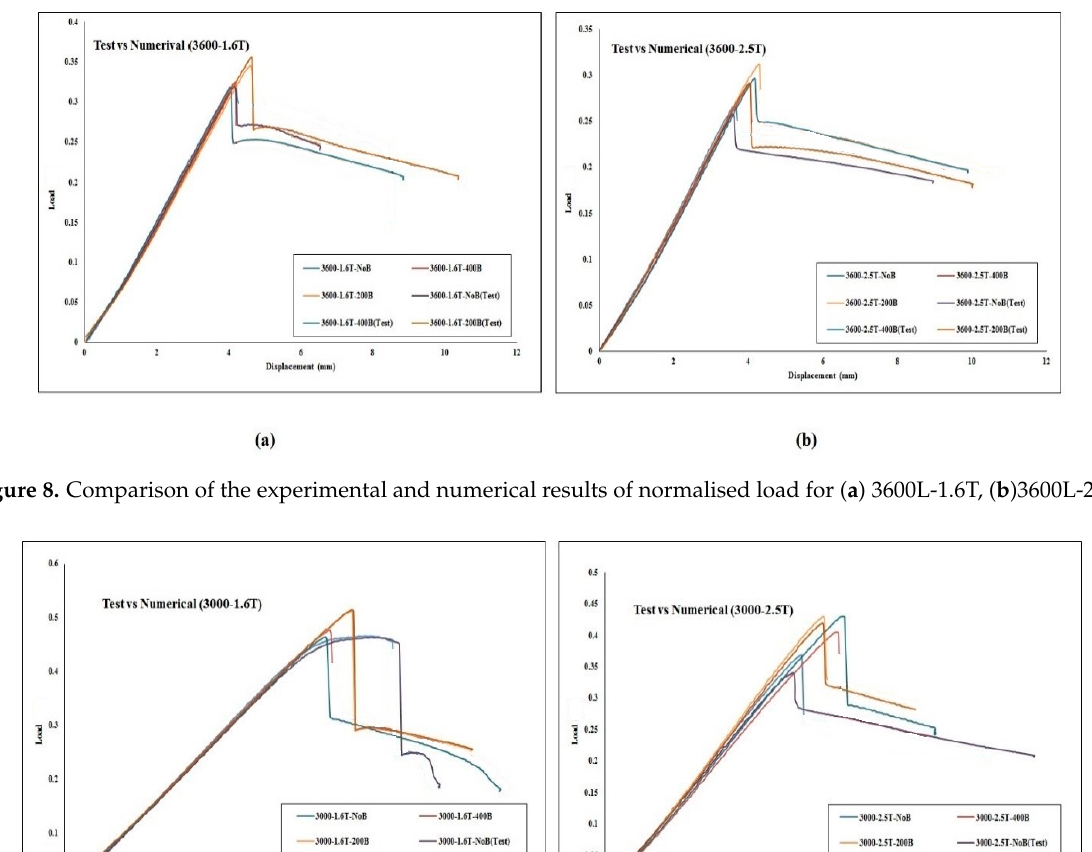
Figure 7. Designation of models